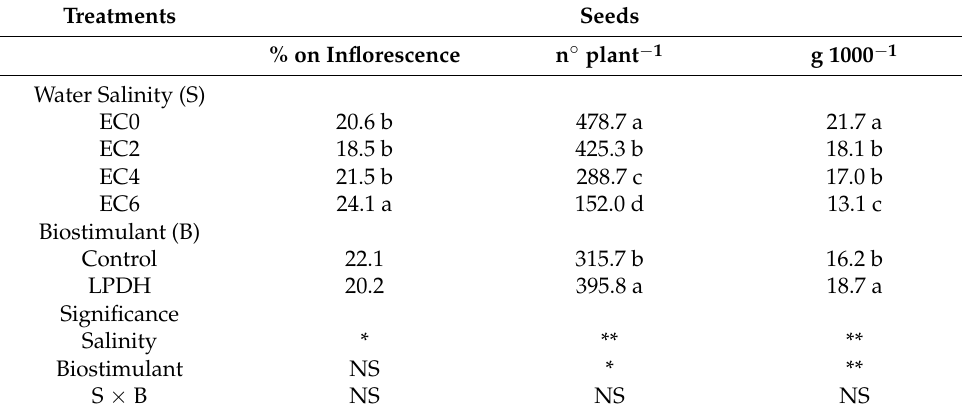
Table 2. Hemp yield parameters (number of seeds per plant, seeds average weight, and percentage of seeds weight on inflorescence weight) at harvest in relation to water salinity (EC0 = non-saline water; EC2 = water at 2.0 dS m − 1 ; EC4 = water at 4.0 dS m − 1 ; EC6 = water at 6.0 dS m − 1 ) and biostimulant application (treated with a commercial legume-derived protein hydrolysate (LDPH) and non-treated (control)).